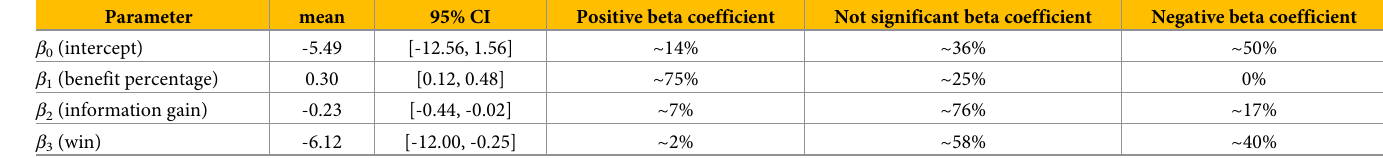
Table 1. Parameters of the GLM model for each subject and percentage of positive, negative, or nonsignificant beta coefficients among subjects.